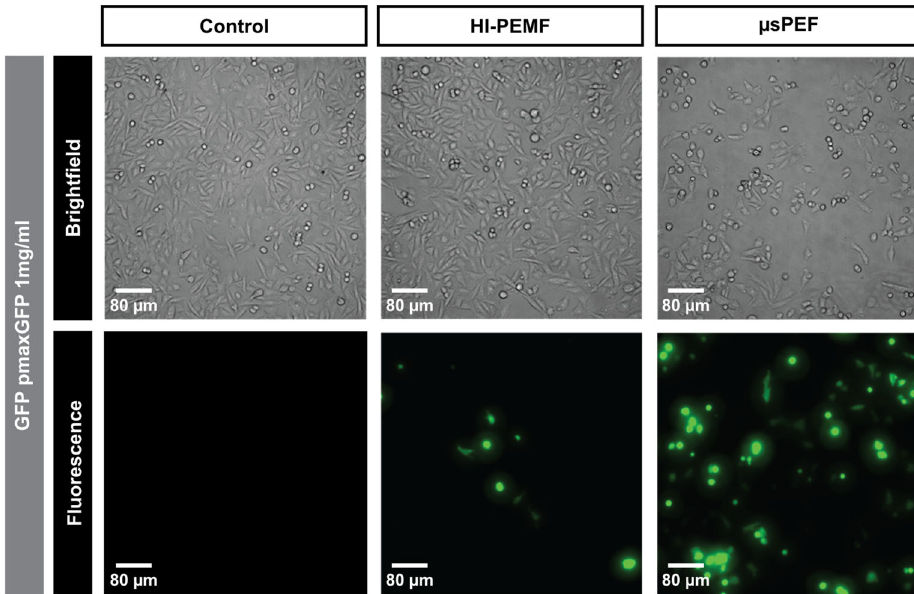
Figure 3. The expression of green fluorescent protein after the application of HI ‐ PEMF and μ sPEF.